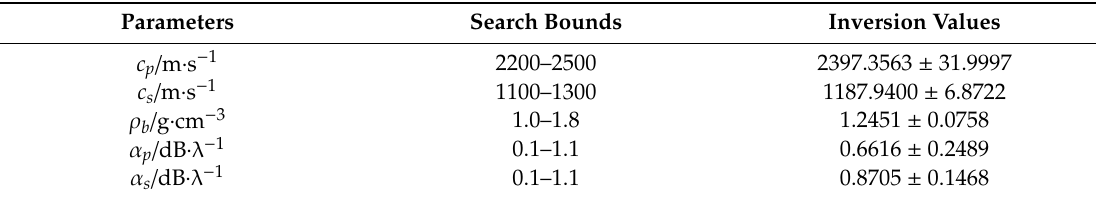
Figure 13. ( a ): The TL measured in the experiment; ( b ): The arrival time of the signal. The red line represents the arrival time of the direct signal, the dashed red line means the arrival time of surface reflection signal, and the dotted red line means the arrival time of the bottom reflection signal. Table 4. Inversion parameters: the search bounds and inversion values are shown.